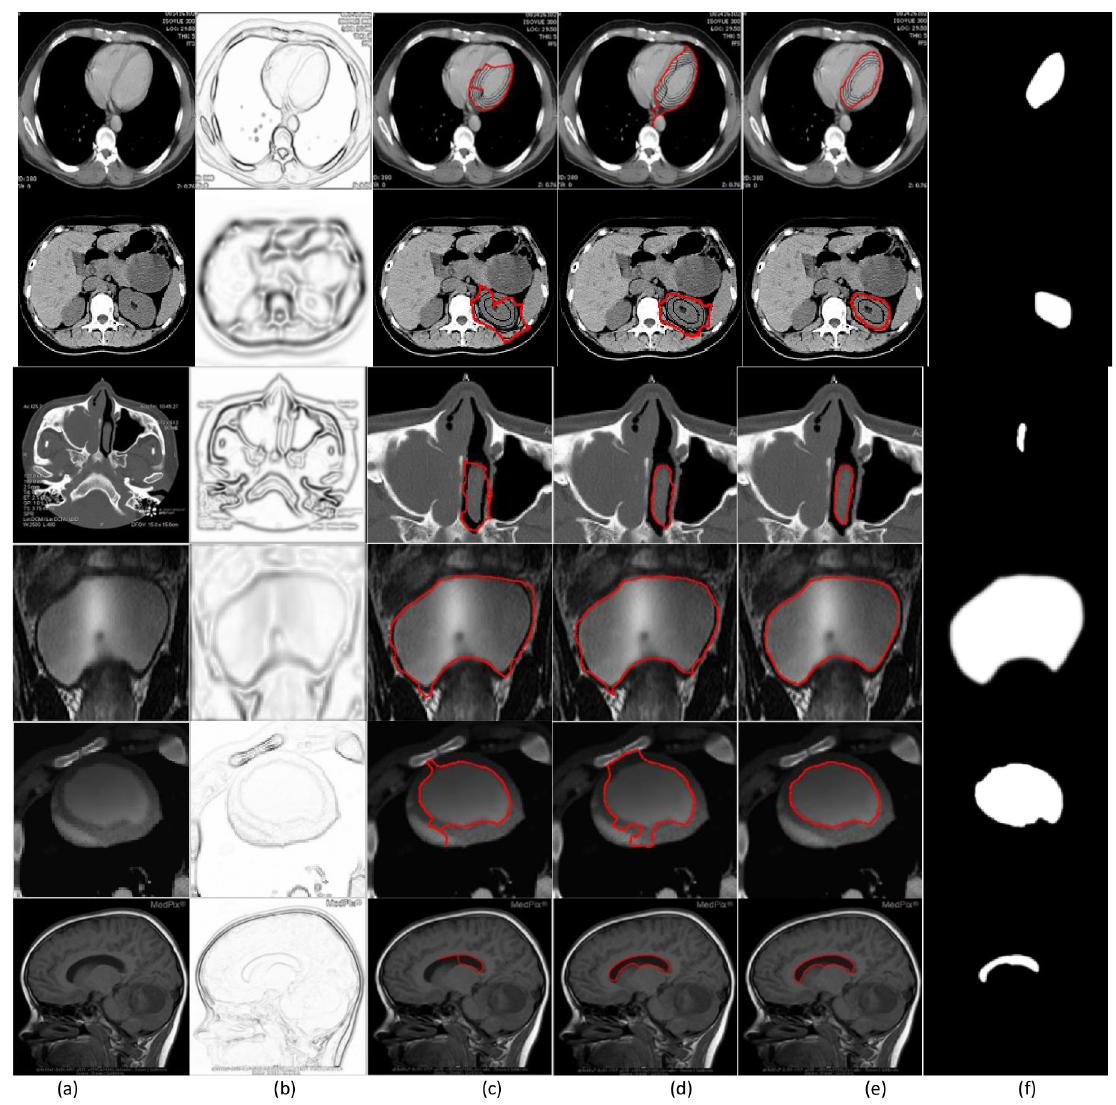
Fig 9. Real medical images. (a) medical images, (b) edge maps, The segmentation results of (c) the GVF snakes with μ = 0.1, (d) the VEF snakes, and (e) the MCONVEF snakes with h = 0.3, k = 0.1, L = 10, (f) ground